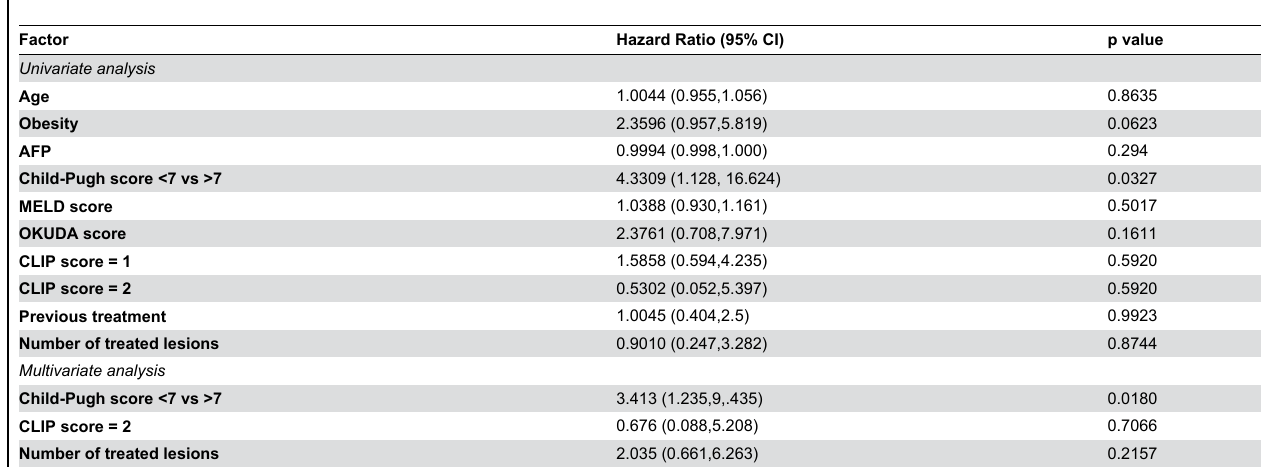
Table 5. Prognostic factors for overall survival (n=75